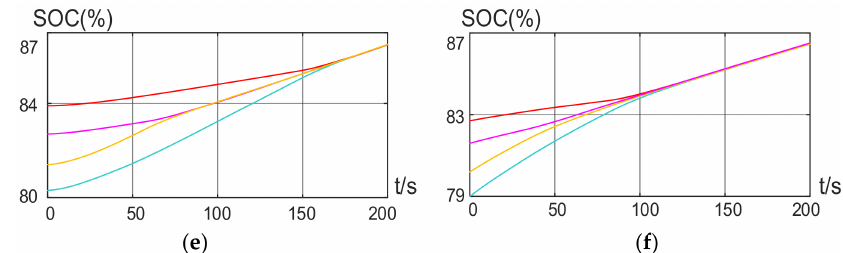
Figure 12. Three-level SOC balancing with power adjustment based on capacity in charge mode. ( a ) The SOC of all 24 battery modules. ( b ) The SOC balancing among the three phase legs. ( c ) The SOC of upper and lower arm in phase A. ( d ) The SOC of upper and lower arm in phase B. ( e ) Submodule